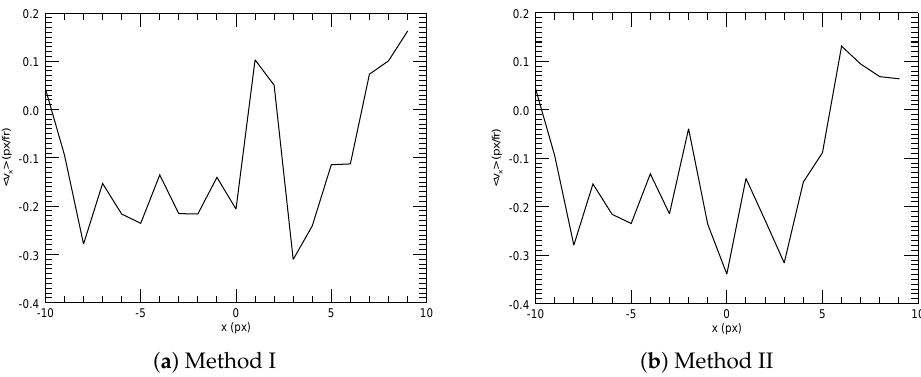
Figure 7. Mean horizontal velocity of traced particles near the point where the two images were joined ( x = 0 px). A jump of about 0.3 px/fr is visible for Method